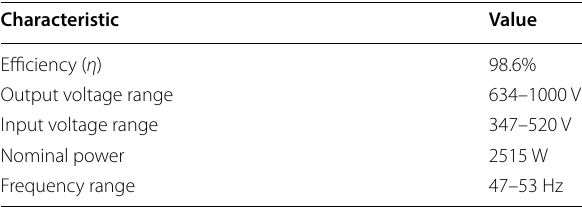
Table 27 Specifications of the AC/DC inverter installed